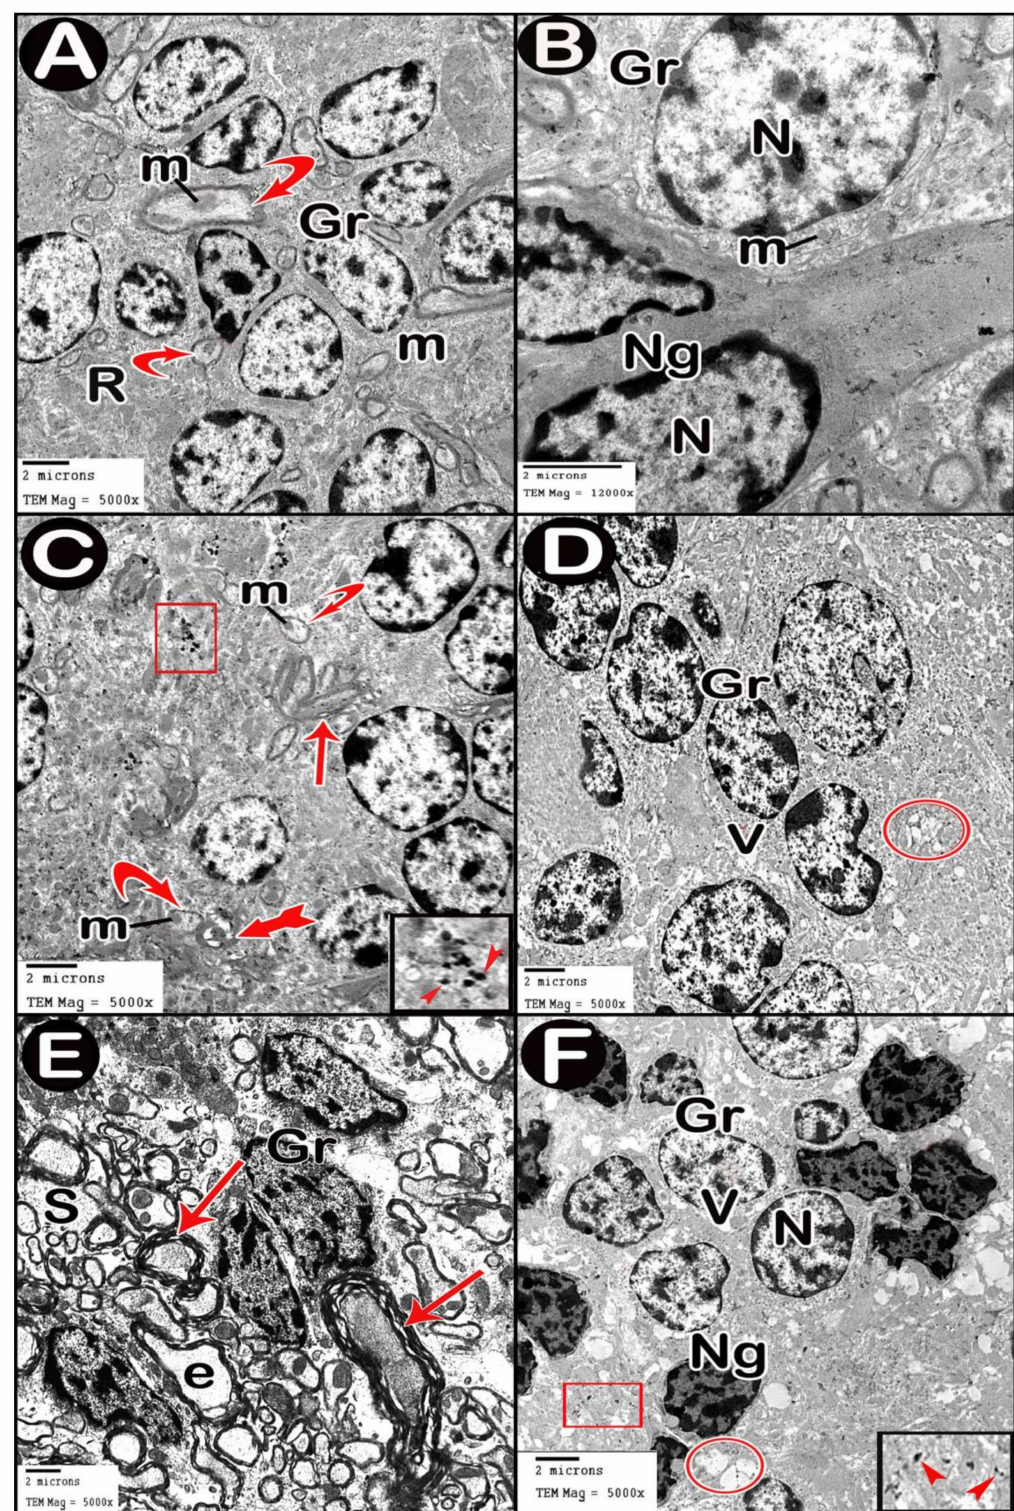
Figure 9. Electron micrographs of granular layer. ( A , B ) control group. ( C , D ) low-dose group. ( E , F ) high-dose group. Granule cells (Gr), mitochondria (m), mossy rosettes (R), neuroglia (Ng), normal myelinated fibers (curved arrow), disrupted myelin (tailed arrow), splitting of myelin sheaths (arrow), vacuoles (V), vacuolated neuropil (circle), ballooned or empty fibers (e) and wide spaces between the axons (S). Insets in C and F, magnifications of the boxed parts showing electron dense silver nanoparticles (arrow